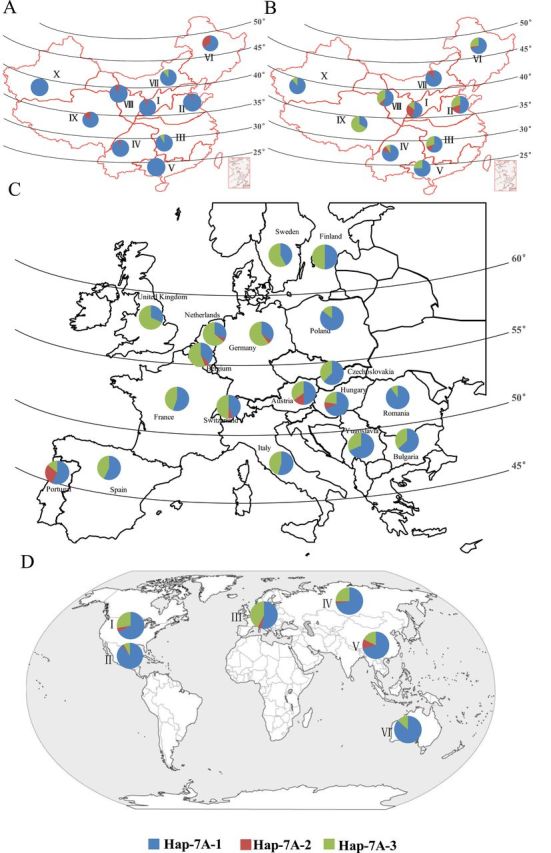
Global distribution of TaTEF-7A haplotypes. Distribution of 157 Chinese landraces (A) and 348 modern cultivars (B) in 10 production zones. I, northern winter wheat region; II, Yellow and Huai River valley winter wheat region; III, low and middle Yangtze River valley winter wheat region; IV, southwestern winter wheat region; V, southern winter wheat region; VI, northeastern spring wheat region; VII, northern spring wheat region; VIII, northwestern spring wheat region; IX, Qinghai–Tibet spring–winter wheat region; X, Xinjiang winter–spring wheat region. (C) Geographic distribution of haplotypes among European wheat cultivars; (D) geographic distribution of haplotypes in cultivars in other regions, I, North America; II, CIMMYT; III, Europe; IV, Former USSR; V, China; VI, Australia.